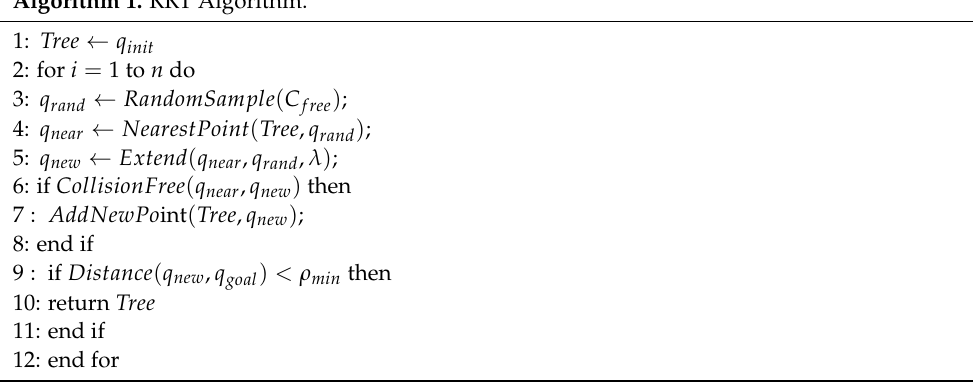
Algorithm 1. RRT